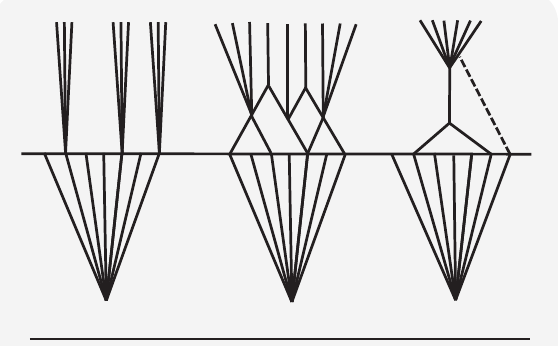
Figure 3. Some predicted schematic trees. Left panel: If complex cells arose in response to a change in environmental conditions, such as oxygenation, one would predict polyphyletic origins of complex cells, in which photosynthetic bacteria gave rise to algae, osmotrophic bacteria to fungi etc. Middle panel: The prediction of polyphyletic origins would also be true for serial endosymbiosis, in which different symbioses occurred in disparate environments. Right panel: the puzzling real- ity — a singular endosymbiosis gives rise to a monophyletic origin of eukaryotes, with no surviving evolutionary intermediates. The dotted line depicts the later endosymbiosis that gave rise to chloroplasts, but this did not affect the origin or early evolution of